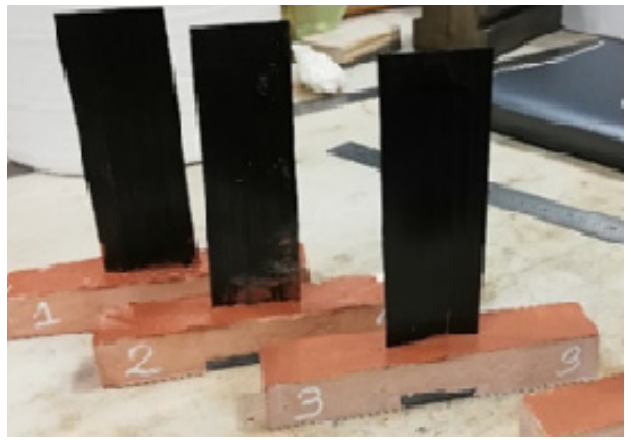
Figure 3. Specimens for the pull-out test.